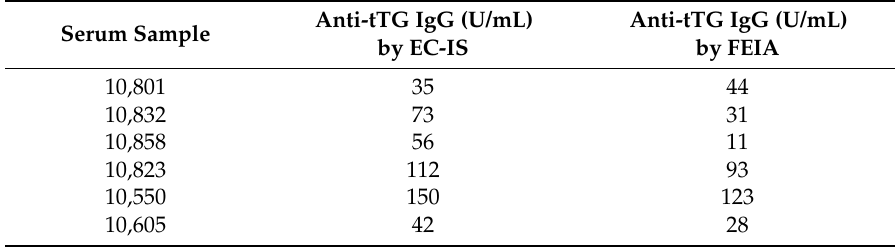
Table 2. Anti-tTG IgG activities measured by the proposed electrochemical immunosensor (EC-IS) and clinical fluoroenzyme immunoassay (FEIA) in human serum samples. Anti-tTG IgG (U/mL) Anti-tTG IgG (U/mL) Serum Sample by EC-IS by